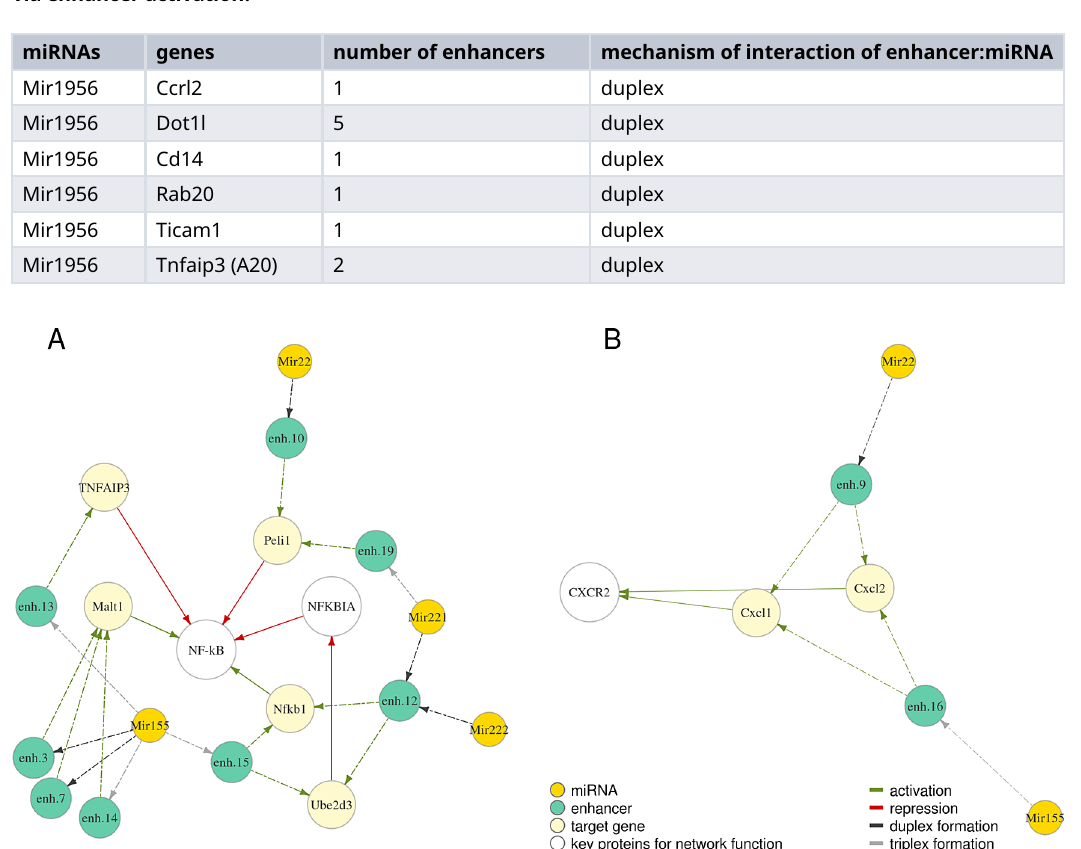
Figure 3. MiRNA-enhancer-gene trios detected for M0 macrophages includegenes withrelated functions and form subnetworks A (related to NF-kB) and B (both genes encode chemokines which signal through CXCR2). Relationships are depicted with arrows of a different colour: green – activation, red – repression. Dashed arrows indicate predicted relationships, solid – known from published studies and described previously. Full coordinates of enhancers are available in Table